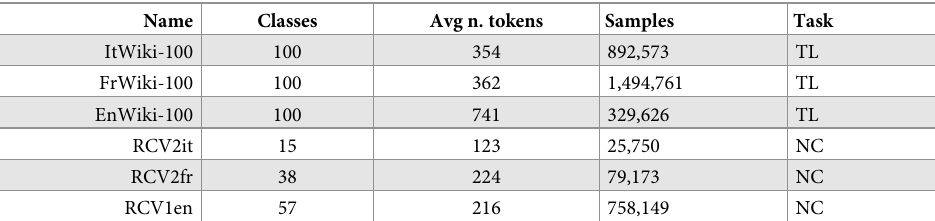
Table 9. Statistics on the examined